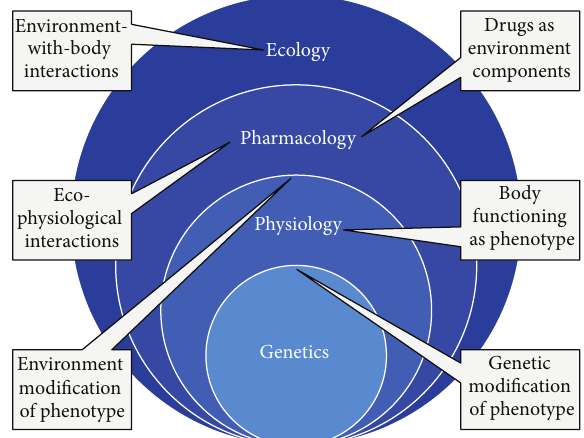
Figure 14: Context of pharmacology as an ecological as well as a physiological phenomenon, with physiology in turn a manifestation of underlying genetics. Pharmacology literally is the exposure of an organism’s physiology to an environmental component, that is, a drug, and the study of organism-with-environment interactions literally defines ecology. Similar though arguably less complex “bubbles” can be placed around both bacterial pathogens and their viruses (e.g., Figure 6). Pharmacology thus is inherently eco-physiological while both the pharmaceutical treatment of distinct living entities, such as pathogens, and the use of drugs that themselves are living, particularly bacteriophages, introduces additional aspects of interface between ecology, physiology, and